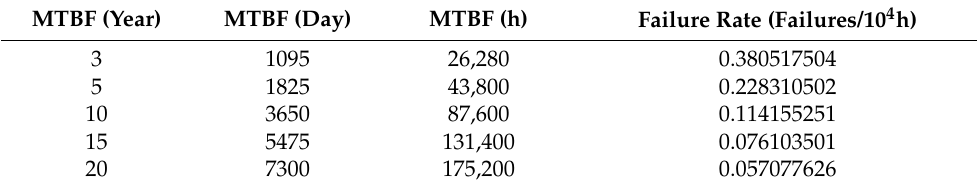
Table 2. Failure rate of [Switching signal generation function failure] corresponding to MTBF.